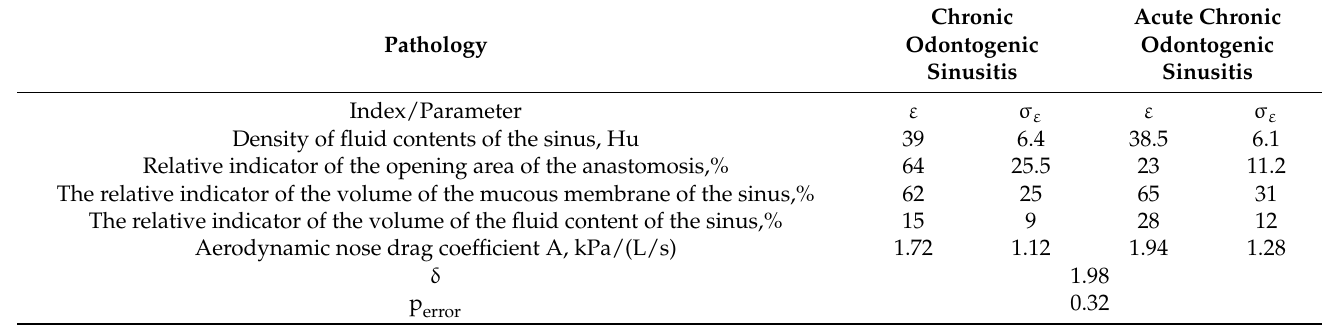
Table 6. Main indicators and results of differential diagnosis of forms of chronic and exacerbated chronic odontogenic